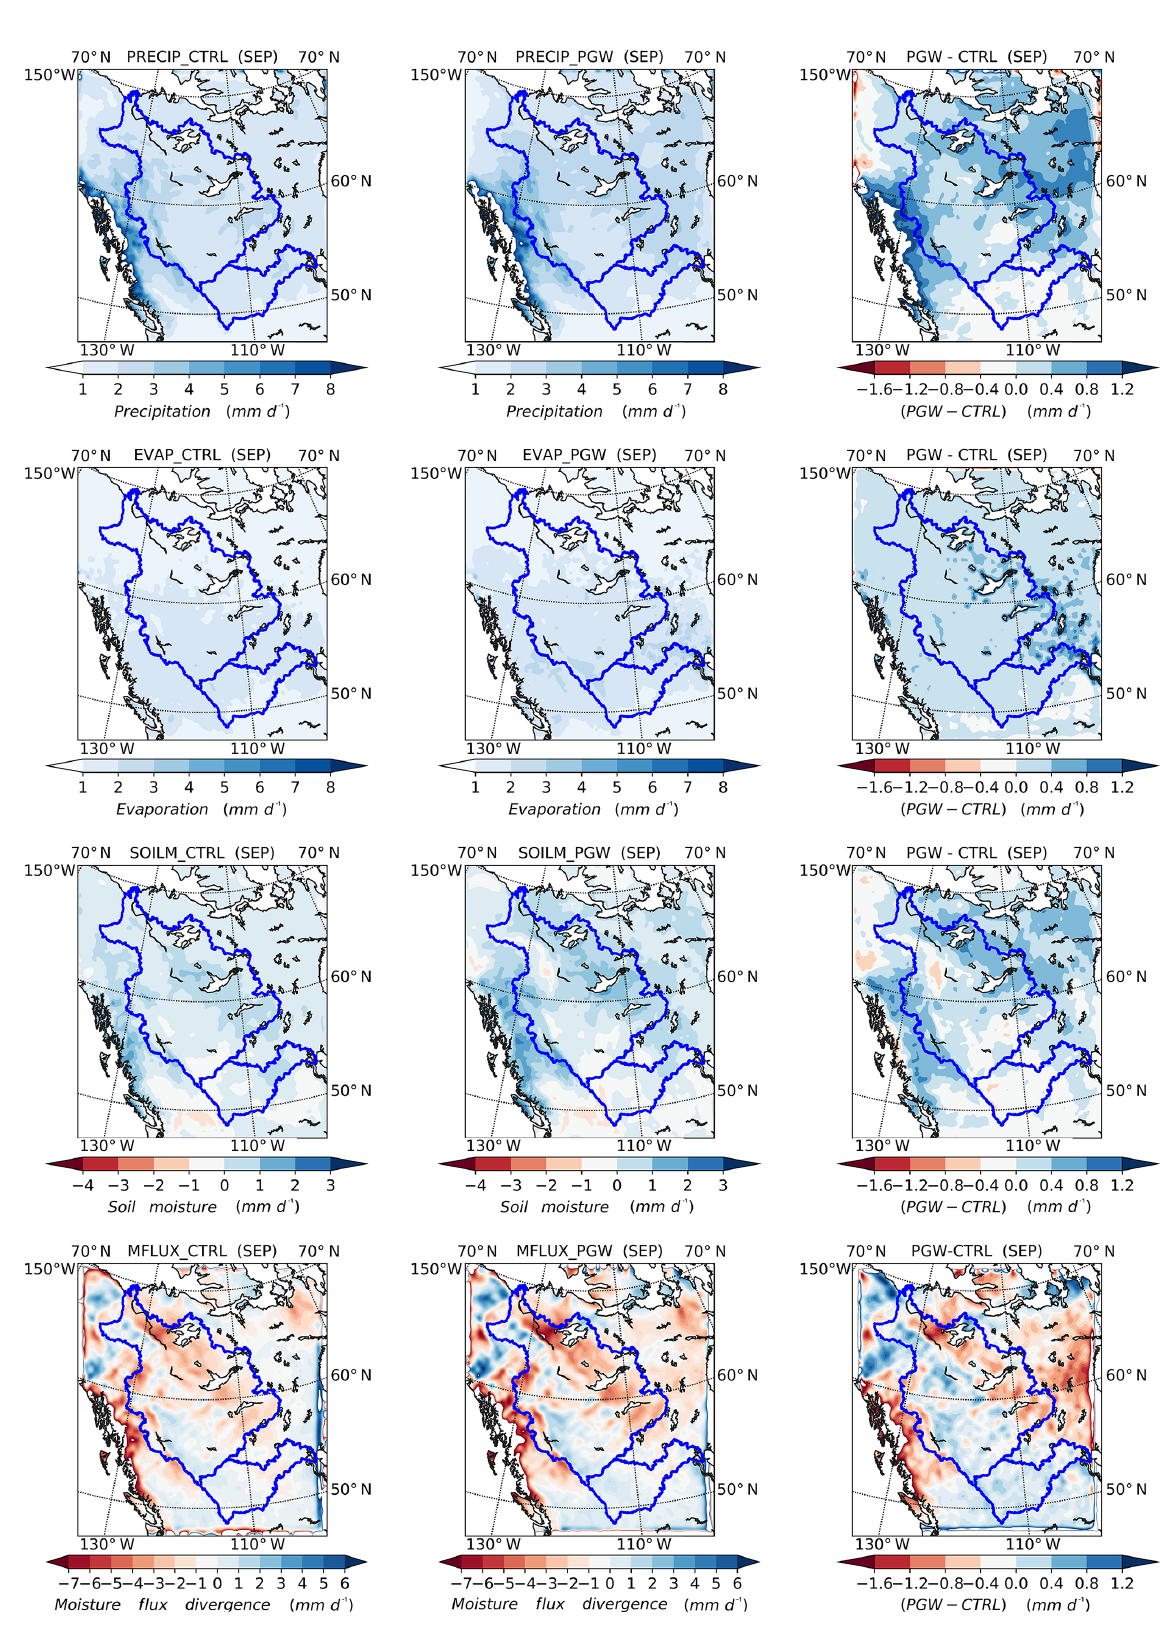
Figure 12. Same as in Fig. 9, except for